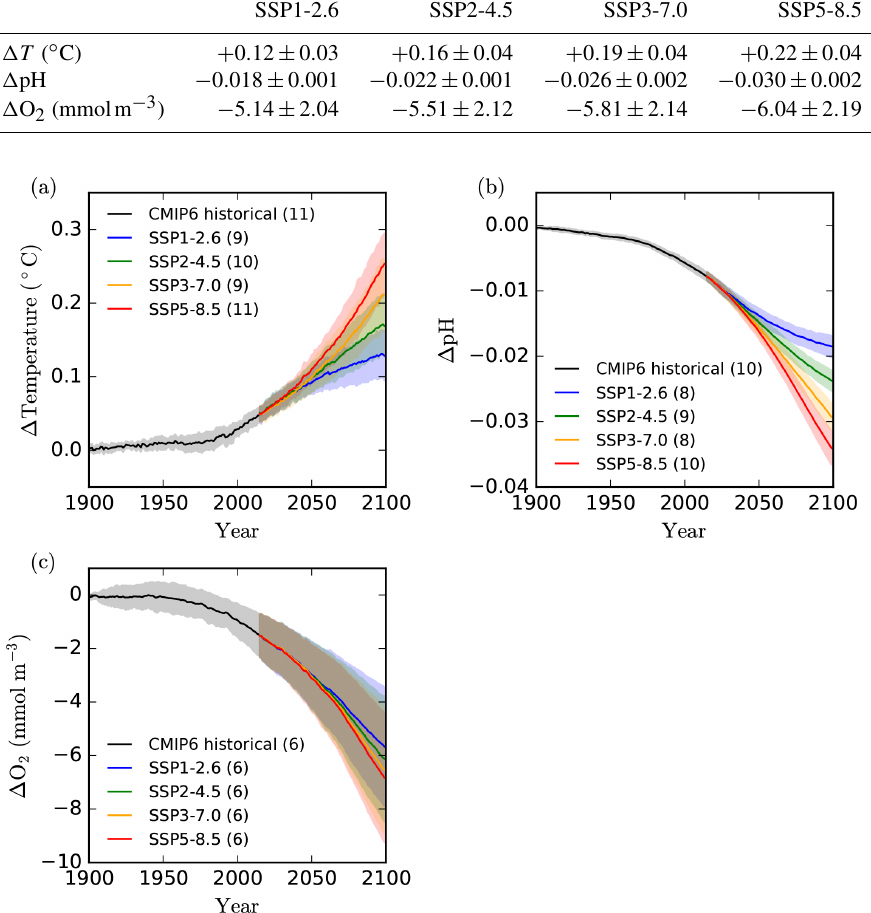
Figure 7. Global mean projections of benthic ocean impact drivers. CMIP6 global mean projections of benthic (a) temperature ( ◦ C), (b) pH, and (c) dissolved O 2 concentration (mmolm − 3 ). Values are anomalies relative to the 1870–1899 reference period. Mean anomalies for the historical and SSP simulations are shown as solid lines, with shading representing the inter-model SD. The model ensemble size for each scenario is given in